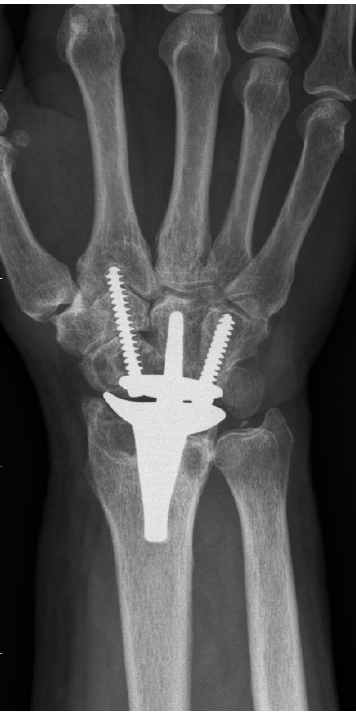
Figure 2. Final radiograph (72 months postoperatively) of a CCR cohort patient with massive ra- dial impaction syndrome. impaction syndrome.